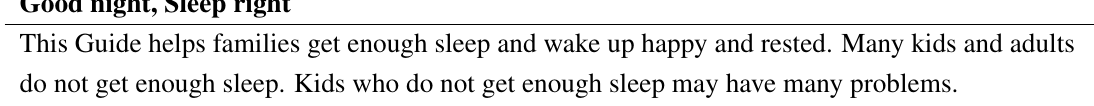
Description and Main